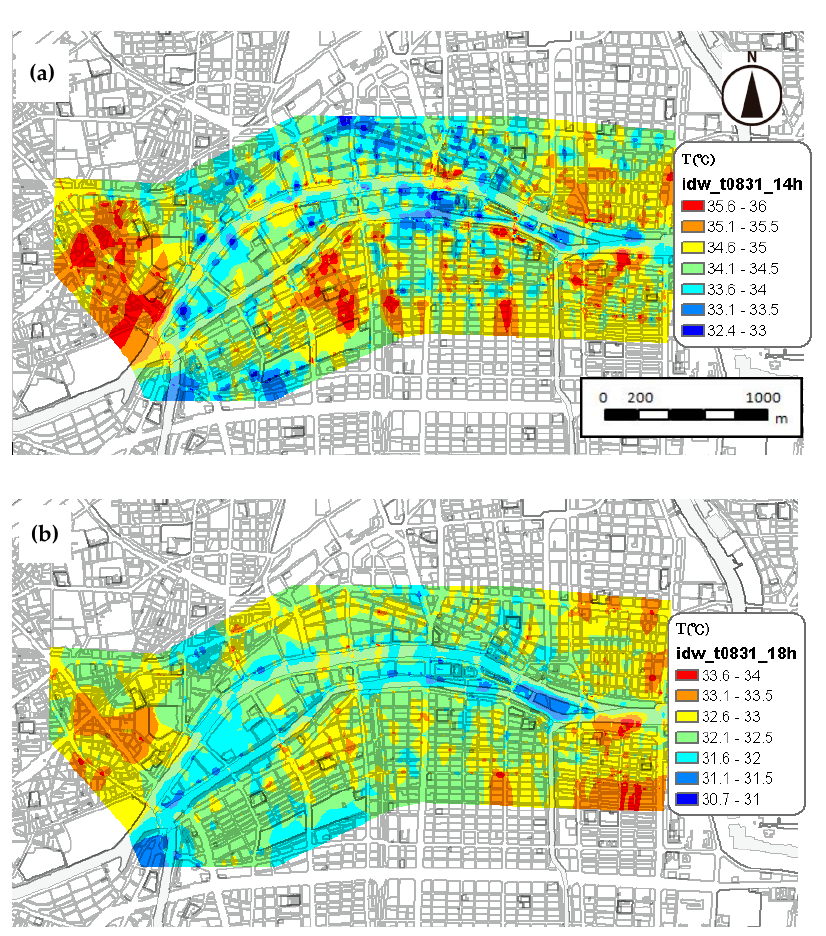
Figure 6. Horizontal distribution of air temperature on 31 Aug. 2010. ( a ) 1400 LST, ( b ) 1800 LST.